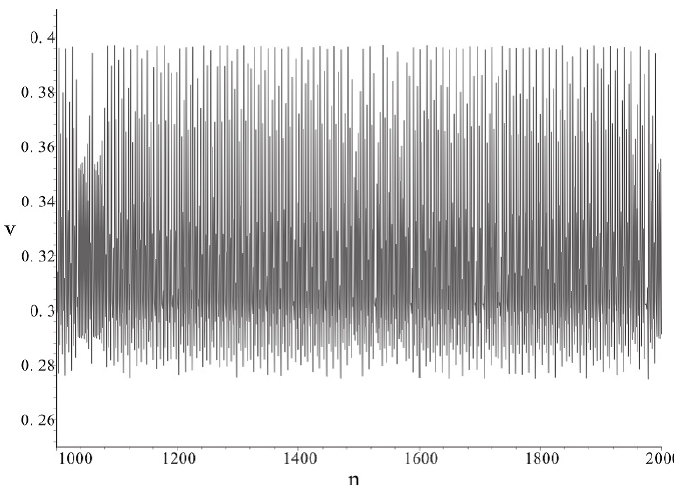
Figure 12. Time series data of voltage map at iterative time n